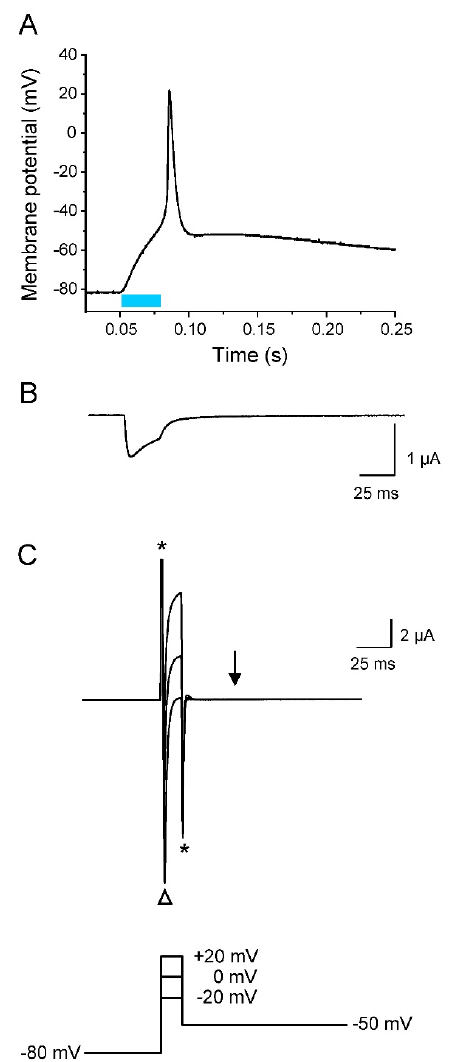
Figure 6. Early but not late AP repolarization by K v 1.2. Recordings were performed on the same oocyte co ‐ expressing Na v 1.5 ‐ CC ‐ 2 and K v 1.2, and plotted using the same timescale in A to C. ( A